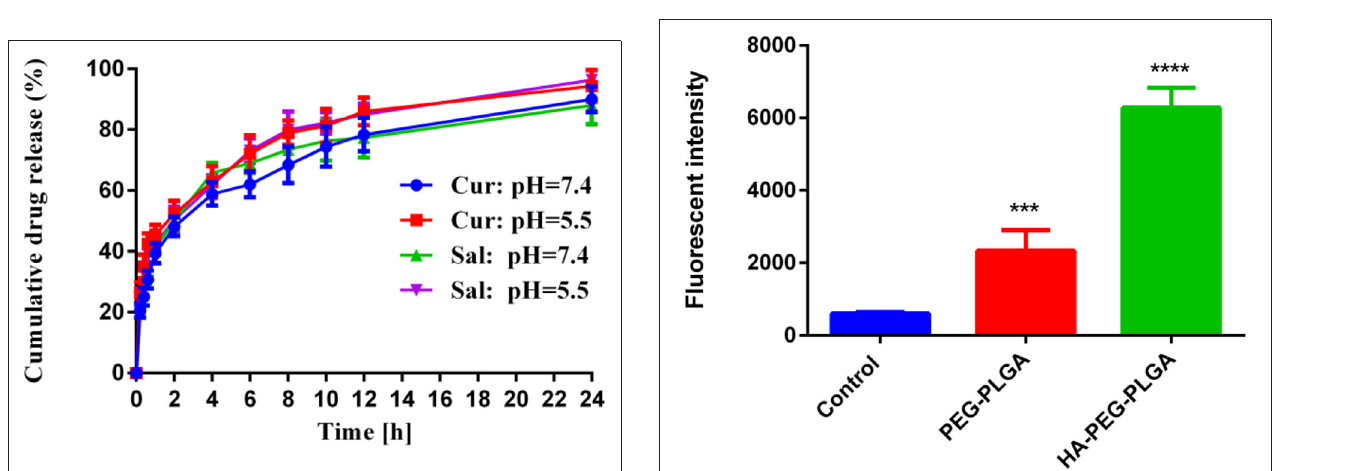
FIGURE 2 | Cell uptake of HA-PEG-PLGA NPs and PEG-PLGA NPs by flow cytometry. The BCSCs were incubated with different formulations for 6h. Data are mean ± SD ( n = 3) (*** p < 0.001, **** p <